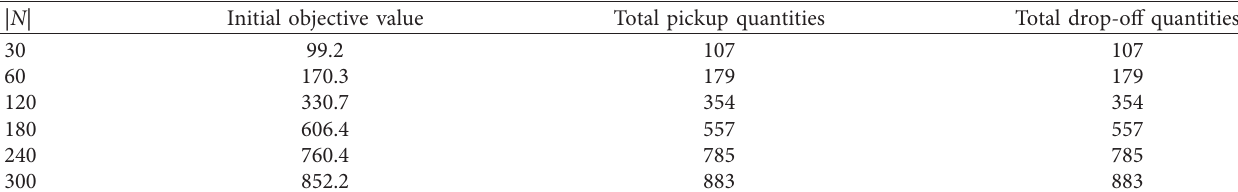
Table 2: Characterization of the